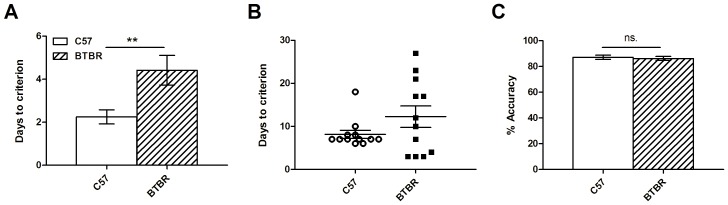
BTBR mice show slower initial learning.BTBR mice (n = 12) took a significantly greater number of days to learn the initial screen-touch, as compared to C57 mice (n = 12; A). There was no significant difference in the number of days taken to learn the “punished” stage of the initial training (B) however the variability exhibited by the BTBR mice is very large compared to C57 mice. Finally, after pre-training was complete, both BTBR and C57 mice showed comparable accuracy performance in the last trial (C) indicating that their performance levels were equal before commencing training on the 5-CSRTT.